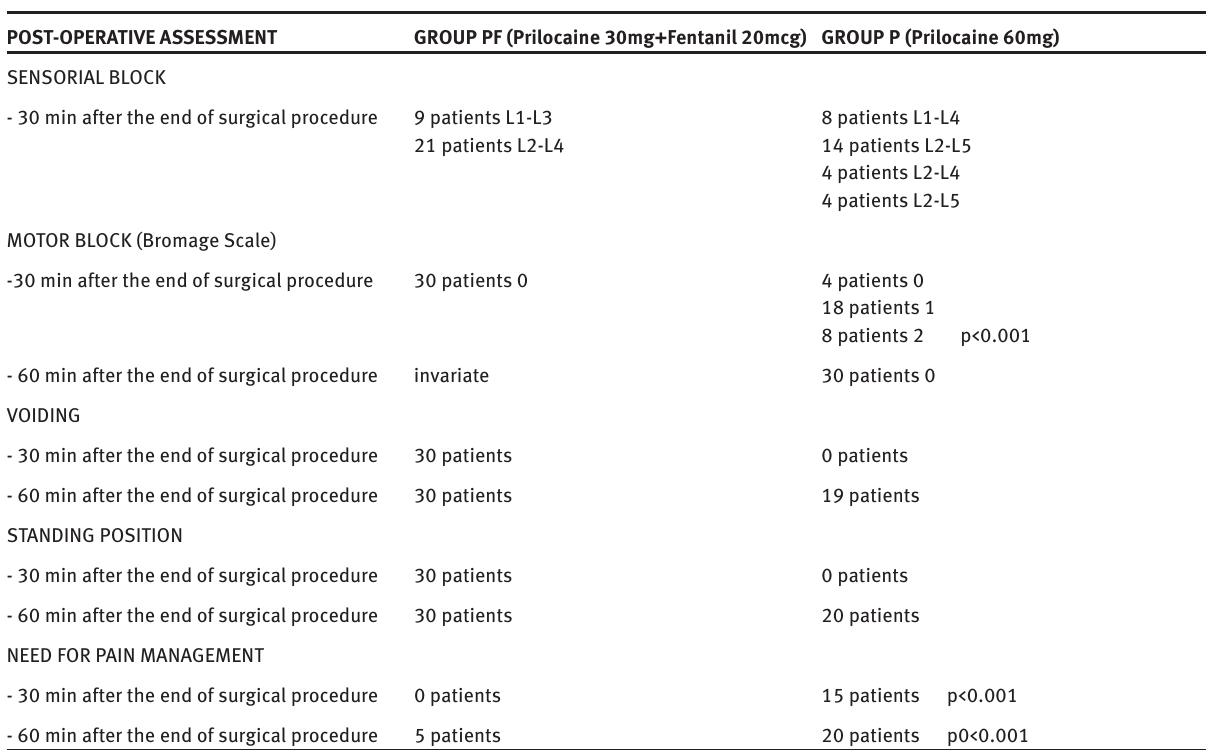
Table 3: Post-operative assessment (sensorial and motor blockages, voiding, standing position, need for pain management). POST-OPERATIVE